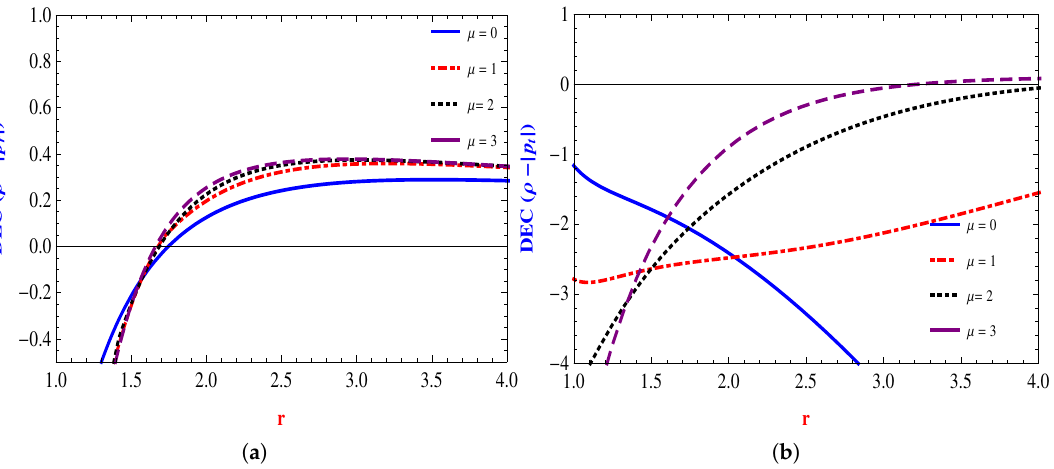
Figure 3. Plots: ( a ) Radial DEC ( ρ − | p r | ) and ( b ) Tangential DEC ( ρ − | p t | ) with throat radius r 0 = 1 and α = 1 in f ( Q ) = α Q